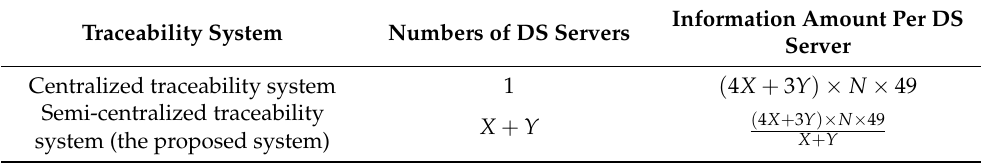
Table 4. The average information amount of different traceability